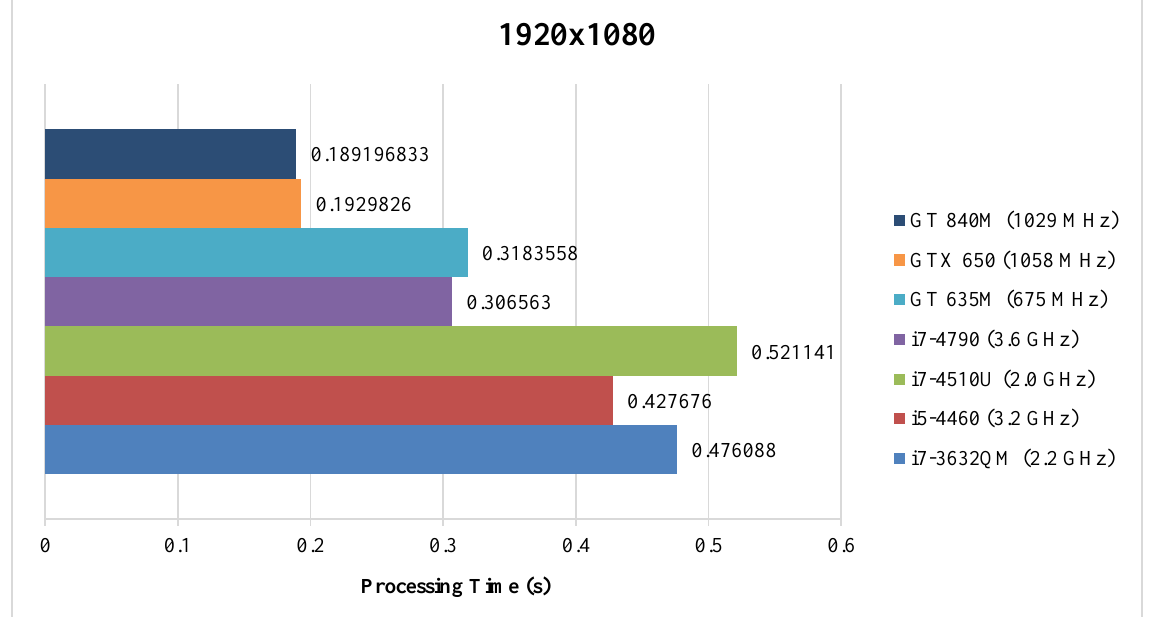
Figure 11. Compare the best runtime of different threads for different CPU and GPU to generate an image in 1080p resolution